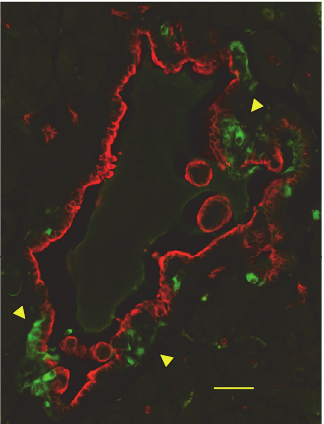
Figure 6: Clusters of insulin-positive cells located near the duct- like structure in Tg mice. Pancreas sections from Tg mice at 40 weeks of age were costained with antibodies to insulin (green) and cytokeratin 17/19 (red). Bar, 40 𝜇